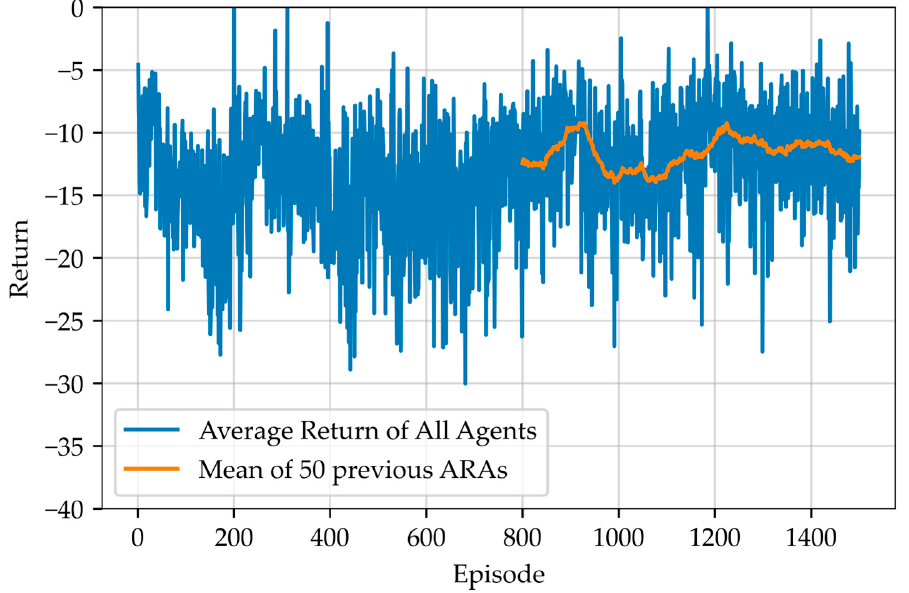
Figure 6. The ARA and MARA of Case II.